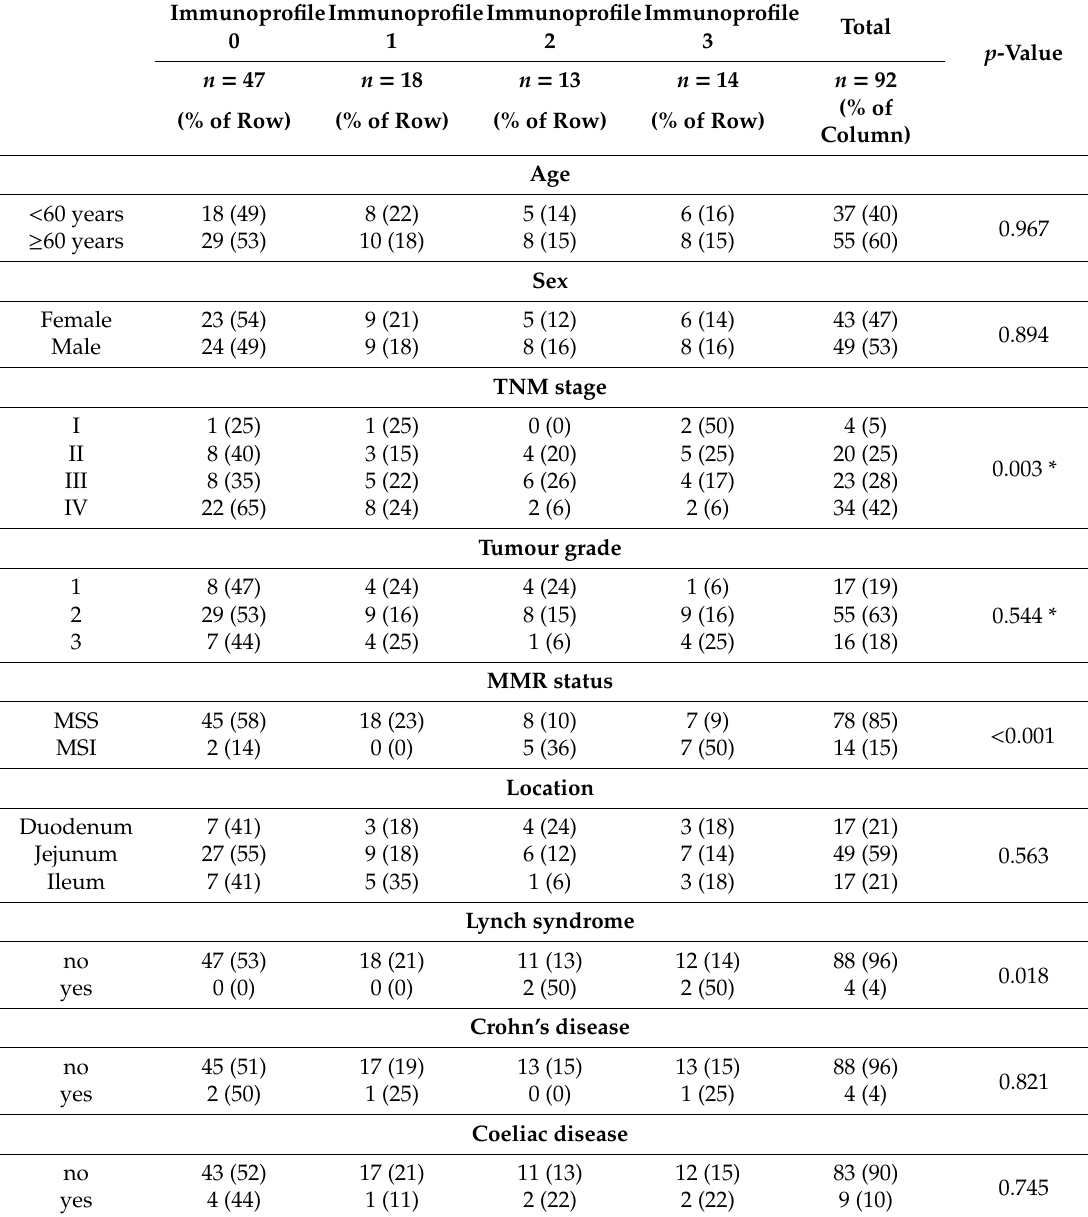
Table 2. Association of clinicopathological variables to